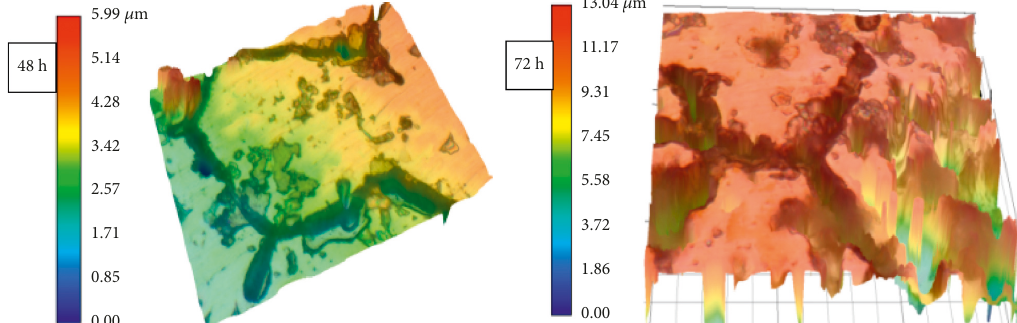
Figure 8: Image of three-dimensional (3D) profiles of sample surfaces.